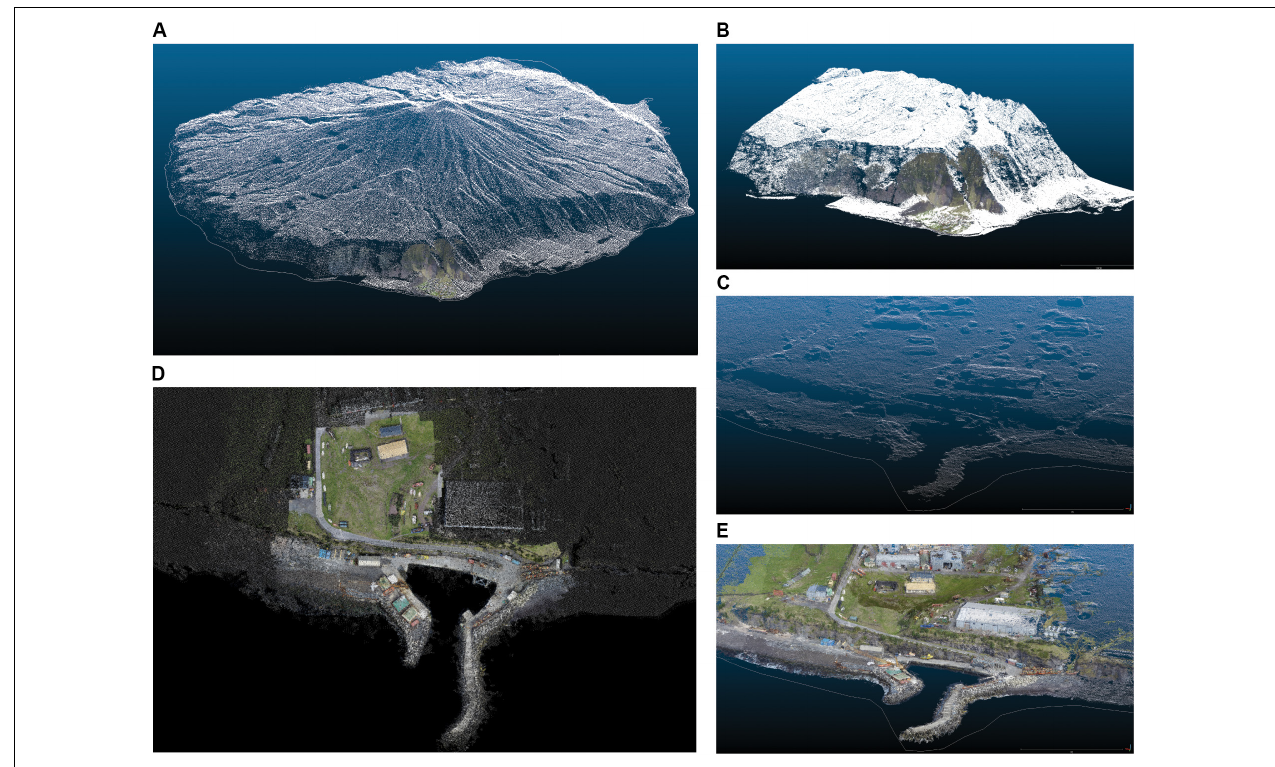
FIGURE 11 | (A) Overview merged point clouds. (B) Area around Edinburgh of the Seven Seas. (C) Perspective view harbor area point cloud from SGM. (D) Top view of the final cloud around the harbor area. (E) Perspective view harbor area blended point clouds.